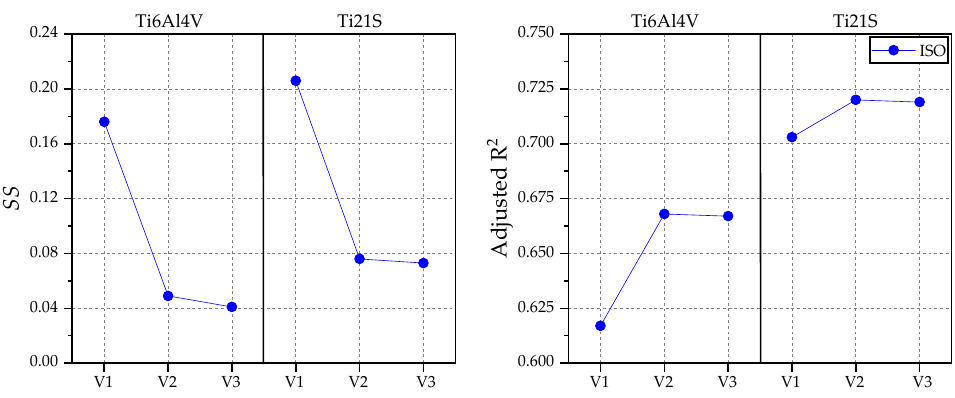
Figure 17. Graphs of the SS and adjusted R 2 for GC2.